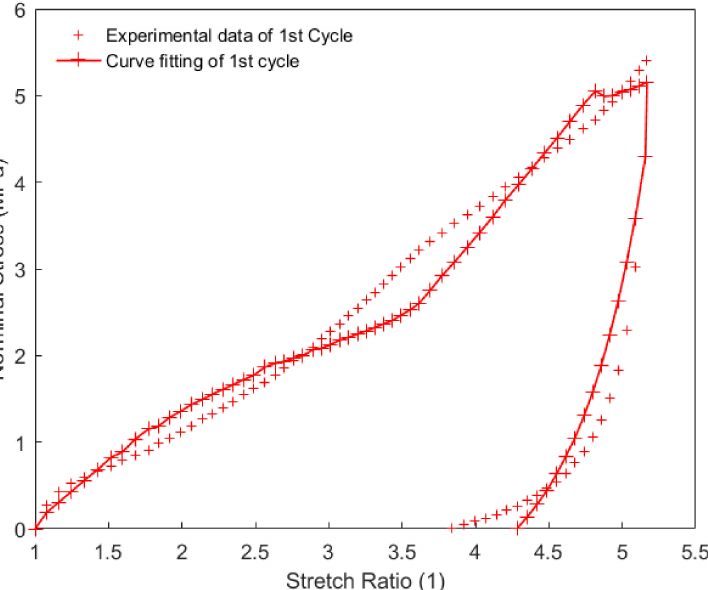
Figure 10. Model prediction of the first cycle during the cyclic tension process of the high-damping rubber material.